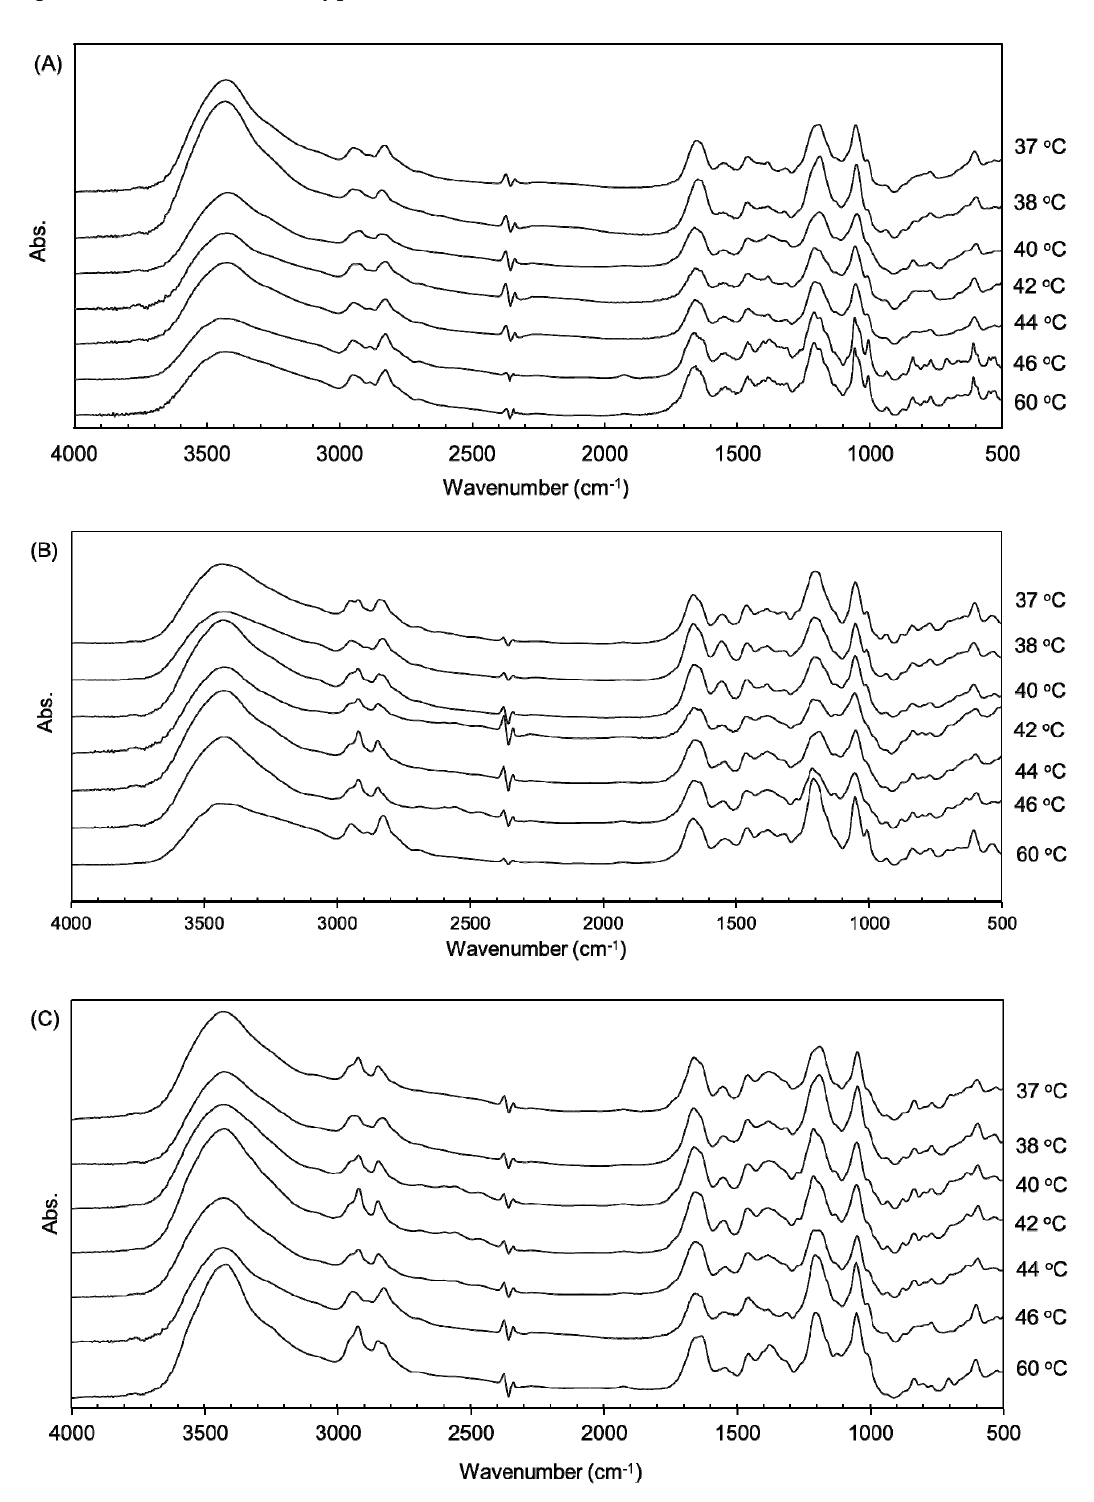
Figure 3. Fourier transform infrared (FTIR) spectra at different temperatures of AuNP-embedded collagen gels made from Cellmatrix type I-A ( A ), Atelocell IAC ( B ), and Cellmatrix type I-C ( C ).